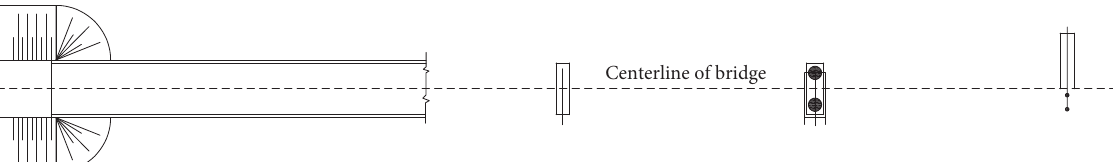
Figure 2: Plan view of Shangban Bridge.